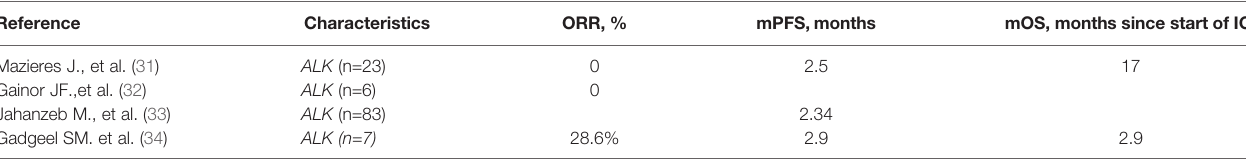
TABLE 1 | Ef fi cacy of ICIs in NSCLS with ALK mutations.